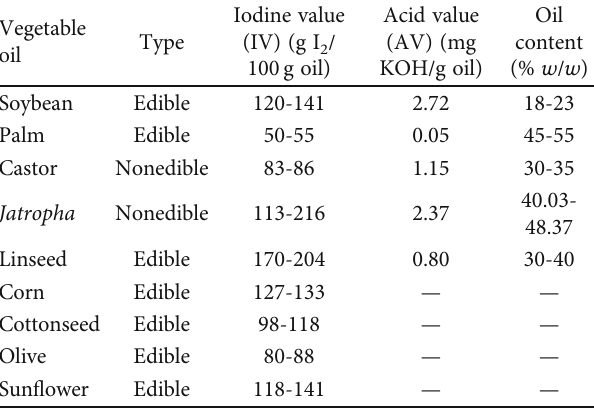
Table 1: Iodine value, acid value, and oil content of common vegetable oils [7 –